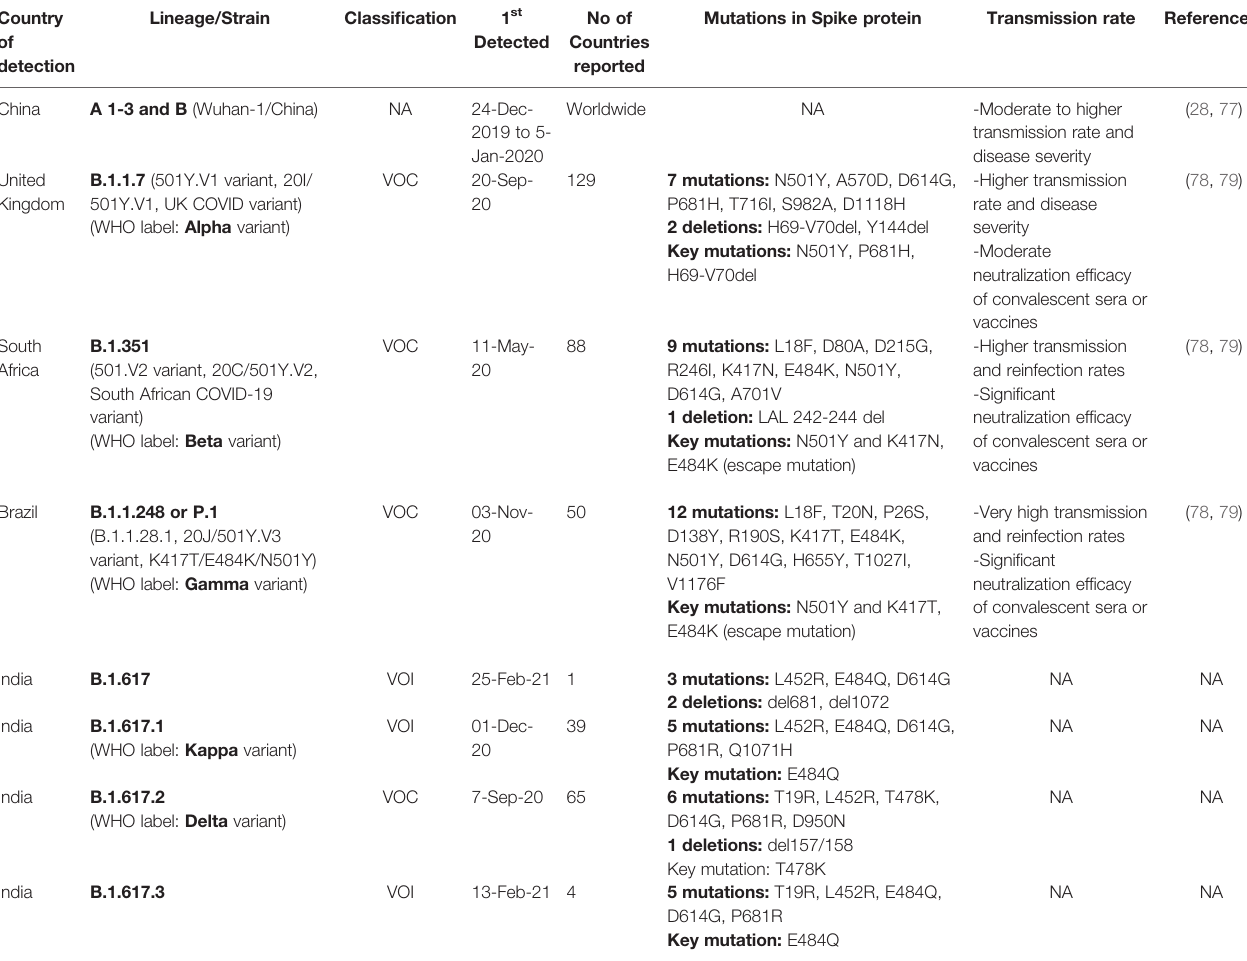
The table is prepared based on literature and information available at https://outbreak.info/situation-reports (accessed on 18-5-2021) and https://covdb.stanford.edu/page/mutation- viewer/#variants.with.adaptive.mutations (accessed on 18-5-2021). VOI, variant of interest; VOC, variant of concern; NA, not